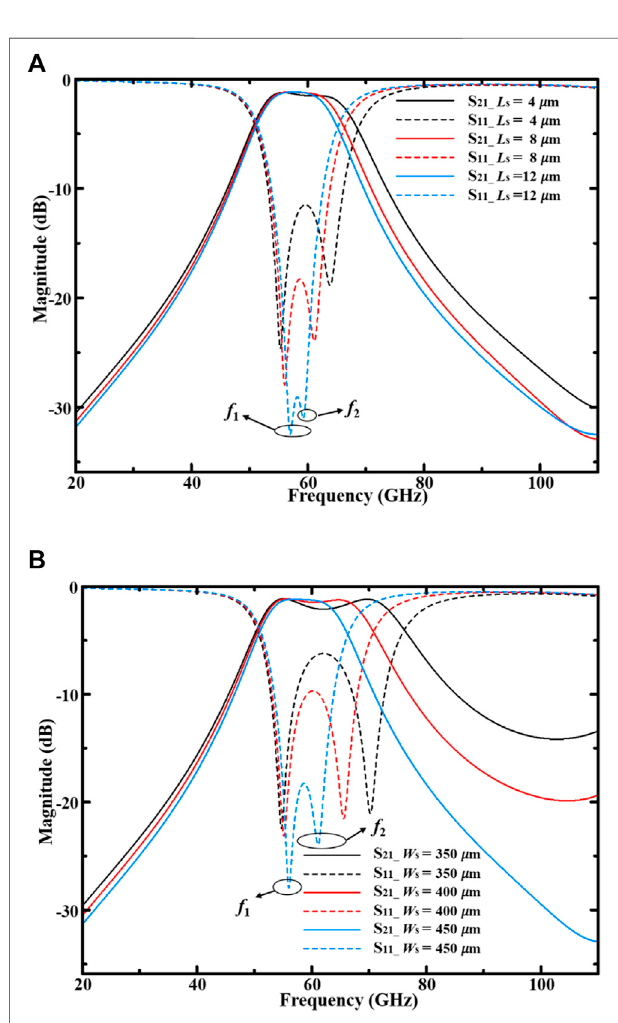
Frontiers in Physics |